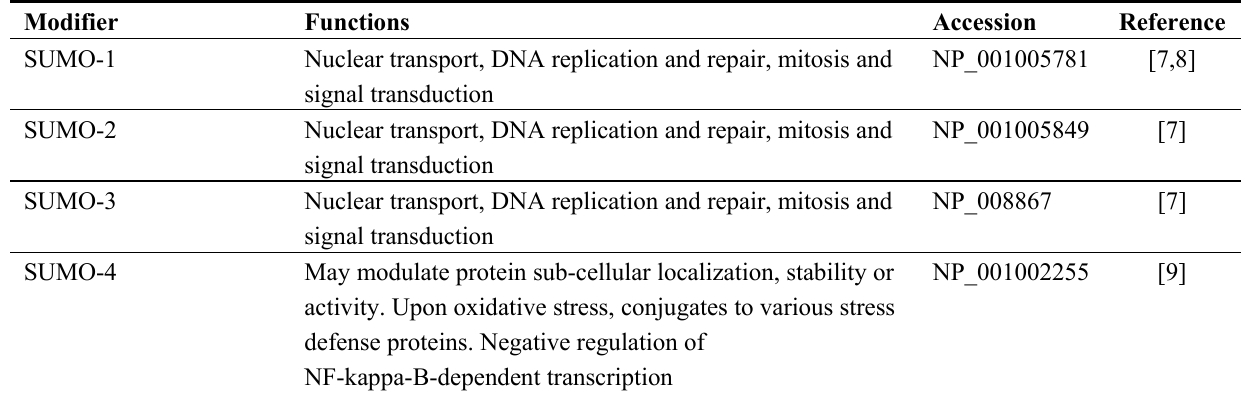
Table 1. List of ubiquitin-like modifiers and their